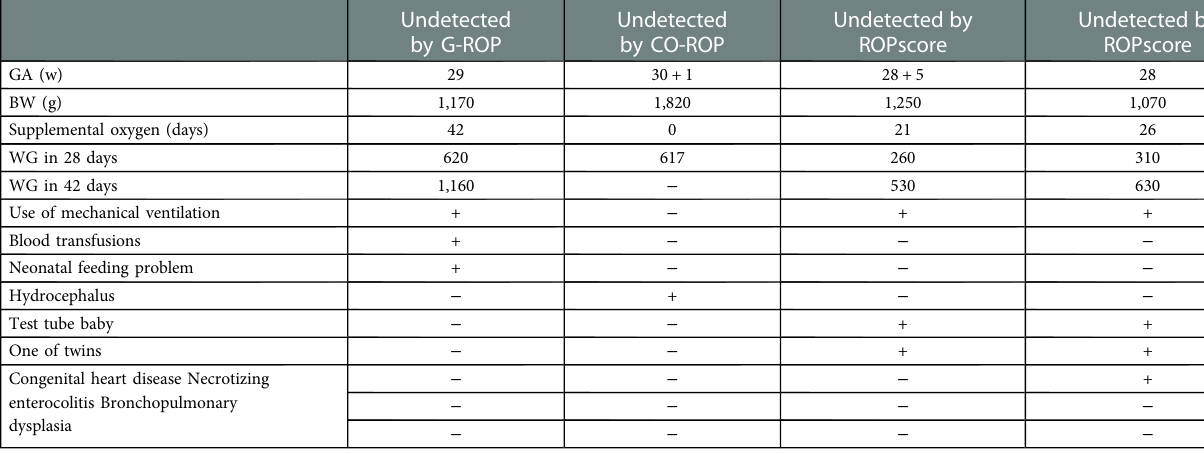
TABLE 4 Risk factors of the 4 infants with severe ROP undetected by different